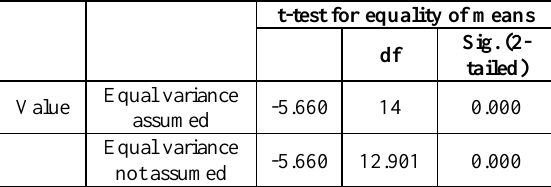
subgroup B4), (subgroup B2 and subgroup B3), and subgroup B4). Table 4: Independent samples t-test between group A and